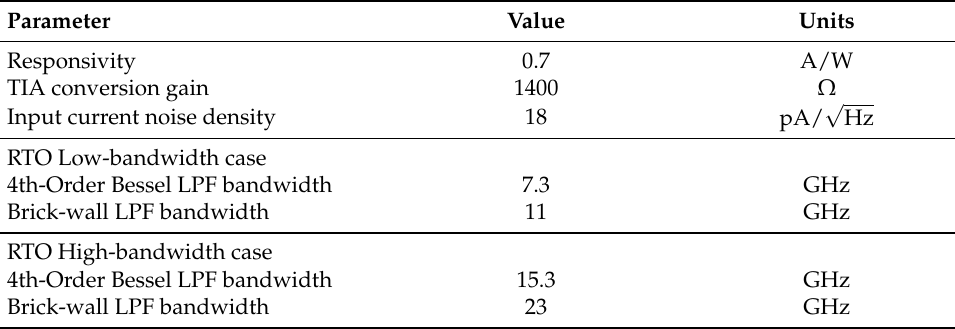
Table 1. Main parameters of the receiver used in the